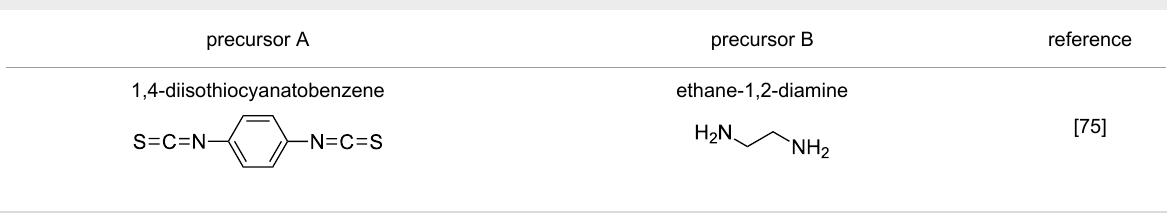
Table 8: Precursors used to deposit polythiourea thin films.